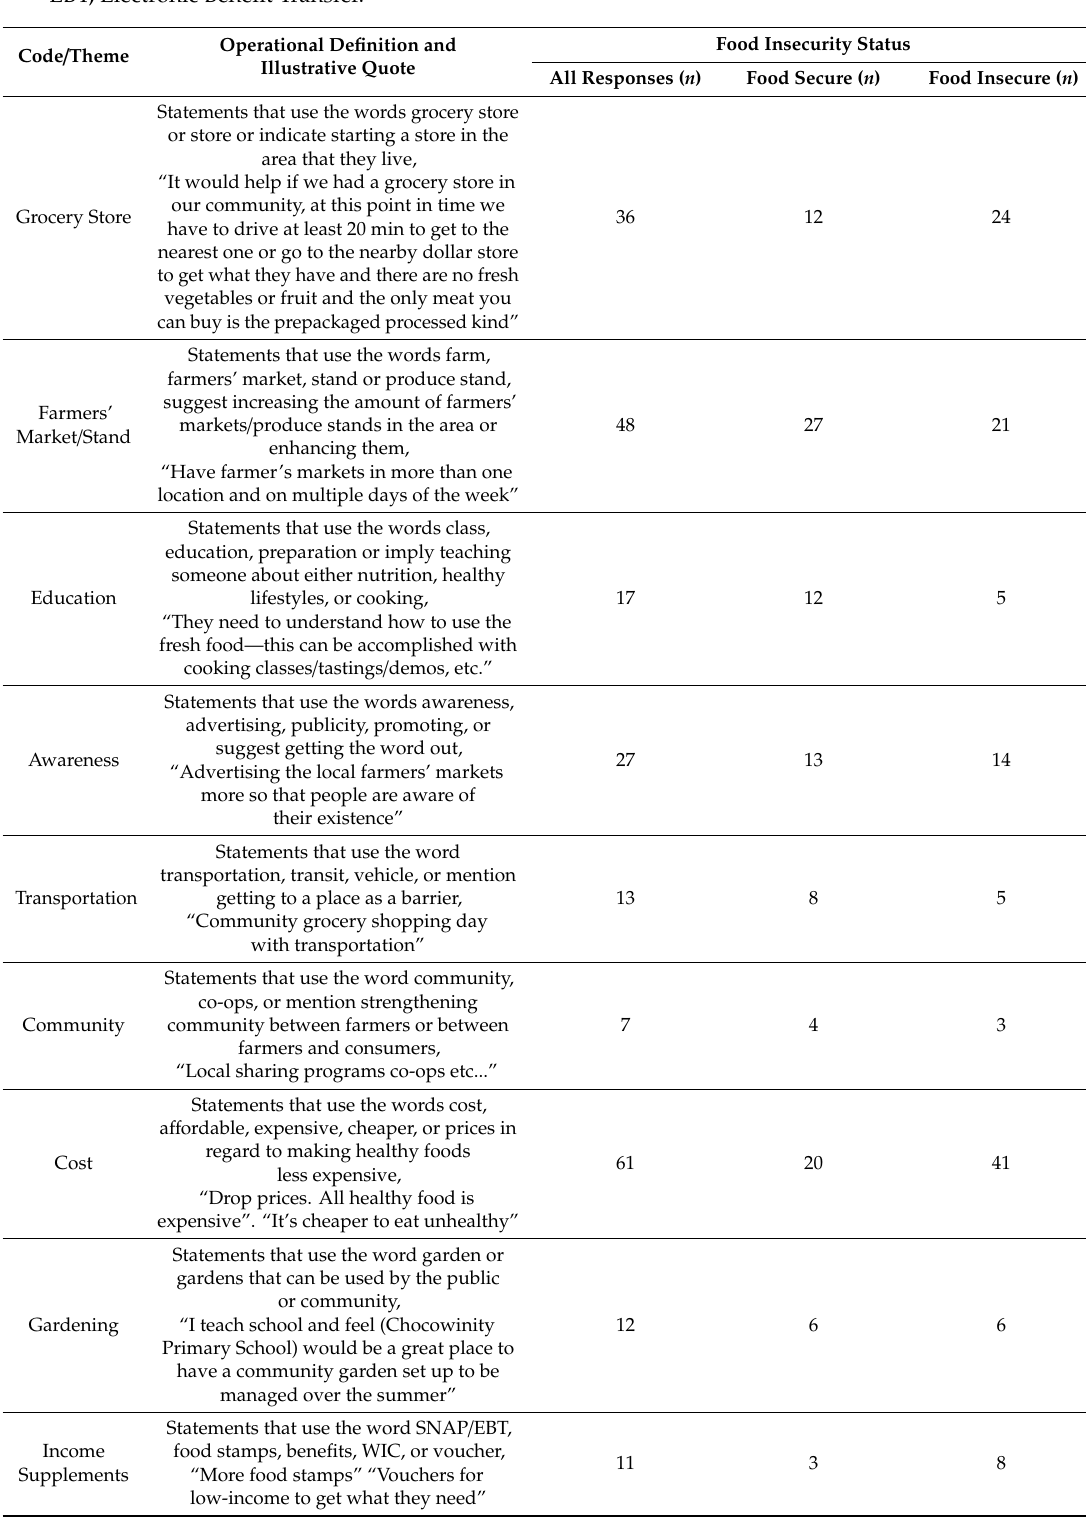
Table 3. Di ff erences in potential solutions proposed, comparing food insecure and secure residents. EBT, Electronic Benefit